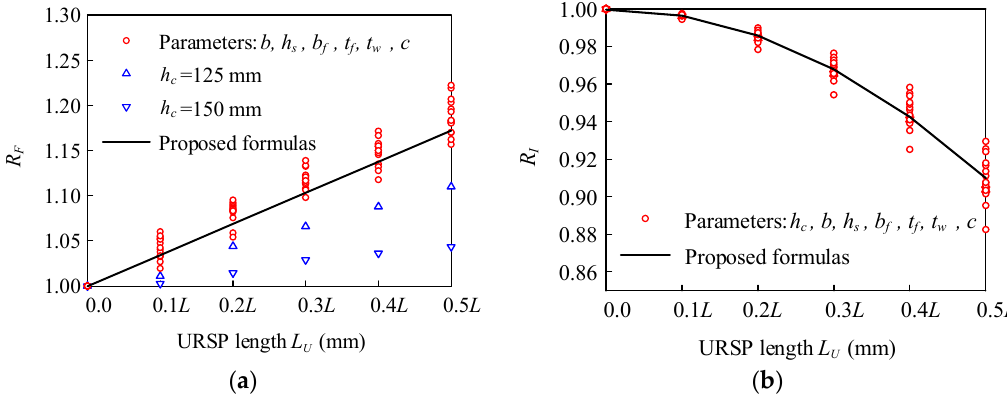
Figure 20. Results of models with a variety of URSP lengths. ( a ) R F ; ( b ) R I.